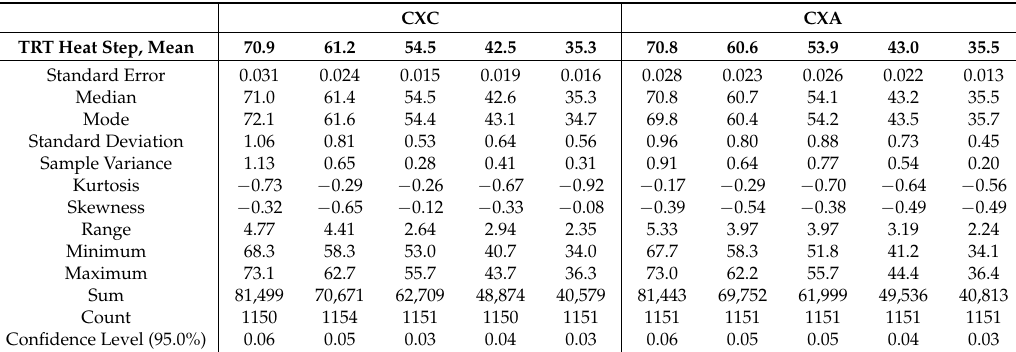
Table 1. TRT heat step descriptive statistics.